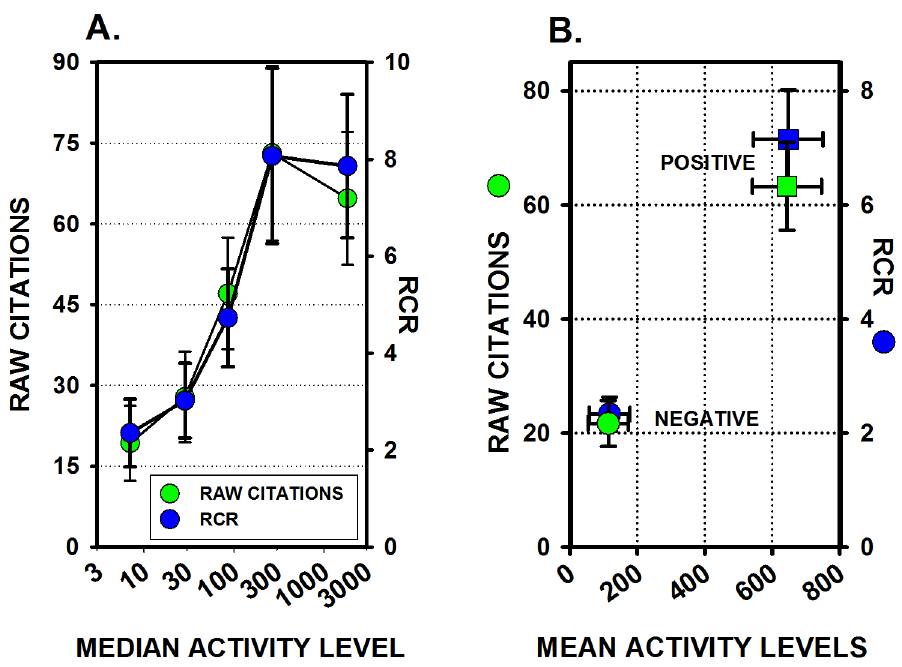
Fig 6. Raw citation counts and RCRs are related to research activity levels. (A) RCR values were calculated approximately 8 years after the papers were published but RCR values and 2-year raw citation numbers were very highly correlated, r(86) = 0.96, and both raw citation numbers and RCR values increased as activity levels increase. (B) Publications reporting positive, statistically significant results were more highly cited than studies reporting negative, non-statistically significant results, and those differences were still evident even with article-level normalized RCR values.